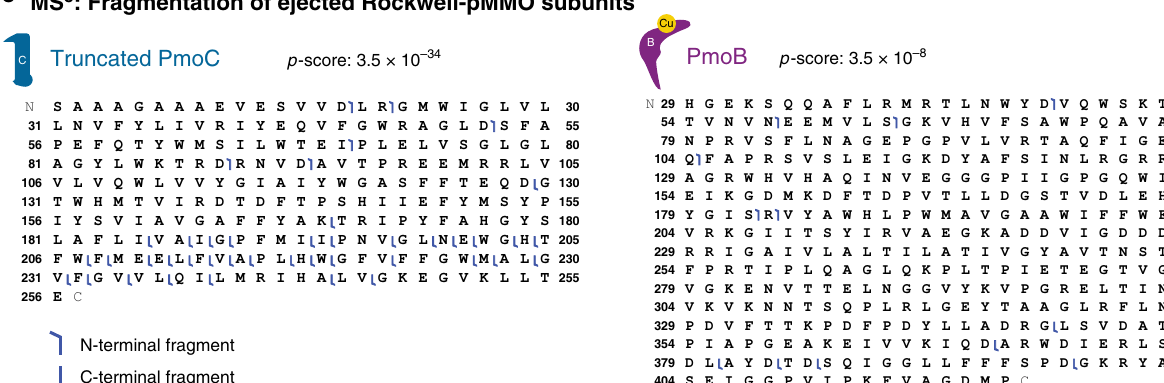
Fig. 6 nTDMS analysis of Rockwell-pMMO in MSP1E3D1 nanodiscs. a Deconvoluted MS 2 demonstrating detection of Rockwell-pMMO subunit masses upon ejection from the nanodisc without or b with copper supplementation during nanodisc reconstitution. The panel on the right contains the theoretical masses of the subunits, accounting for the modi fi cations characterized by tandem MS. The two species shifted in mass from PmoC by + 17 and + 34 Da likely correspond to the replacement of one and two protons by ammonium adducts (Th. 17.03 Da and 34.06 Da, respectively) on PmoC commonly observed in nESI 65 . c The MS 3 of truncated PmoC and PmoB yielded fragment ions, depicted as blue fl ags in the graphical fragment maps that indicate which regions of the protein sequence can be accounted for in mass by the fragments. Truncated PmoC lacks the fi rst fi ve residues of the N-terminus (MSSTT), and its graphical fragment map begins at residue Ser 6. The graphical fragment map of PmoB begins at residue His 29, consistent with the cleavage of the known N-terminal signal